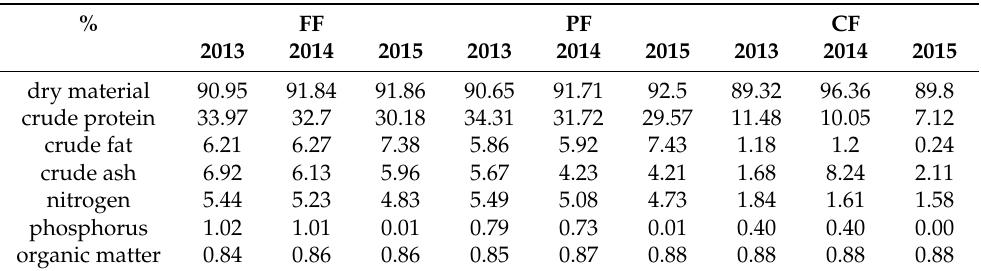
Table 2. Proximate composition (percentages given for wet weight) of all three feed types (FF: feed with fish meal, PF: plant-based feed, CF: cereal